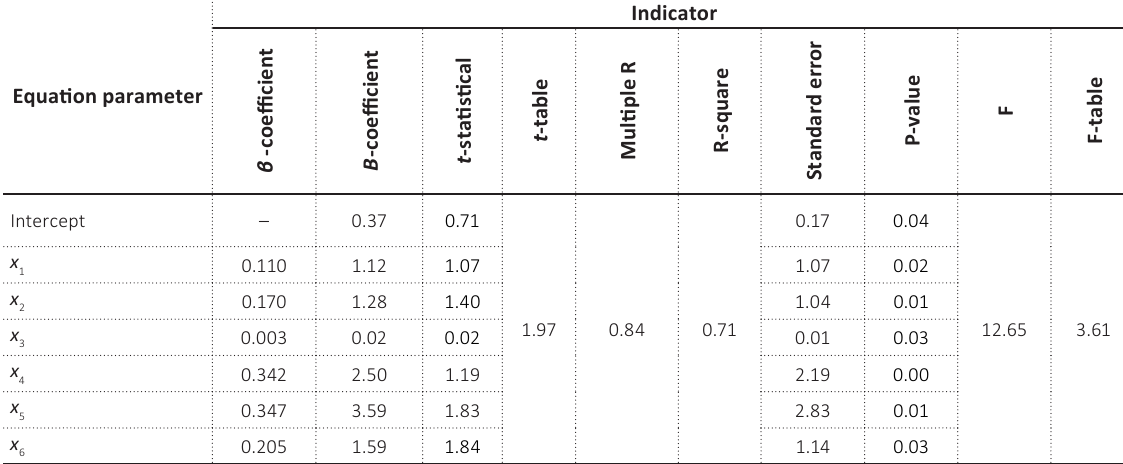
Equation parameter